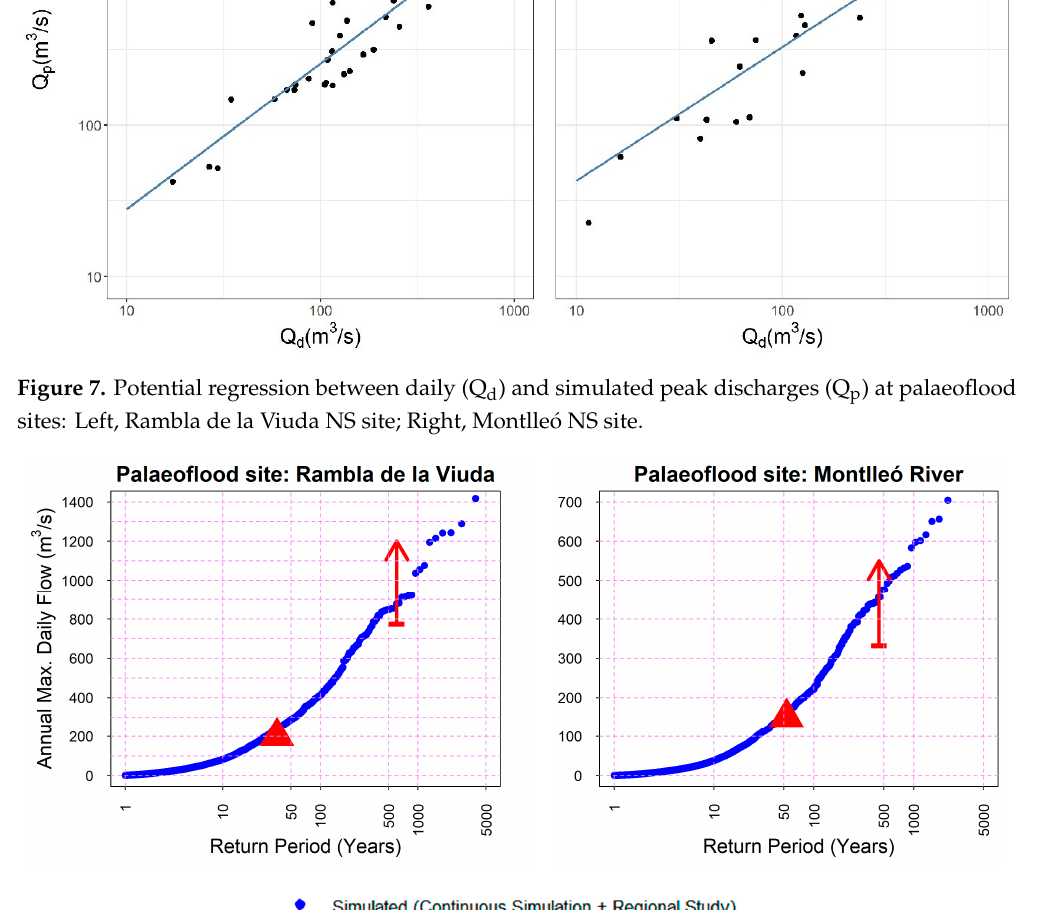
Figure 7. Potential regression between daily (Q d ) and simulated peak discharges (Q p ) at palaeoflood sites: Left, Rambla de la Viuda NS site; Right, Montlleó NS site.